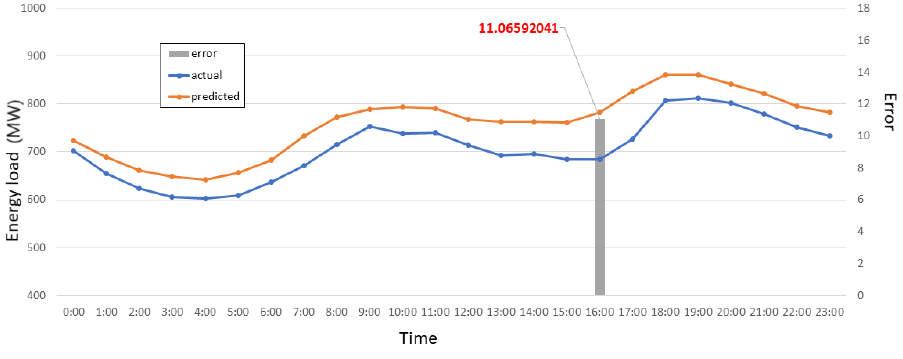
Figure 21. Peak error recorded on Thursday, 12 December 2019